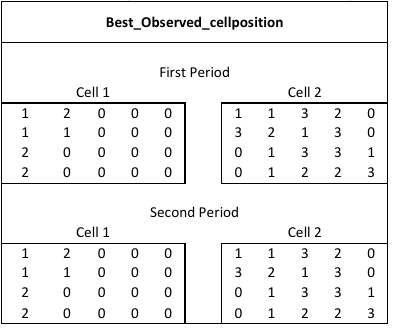
Part-routes observed for the experiment